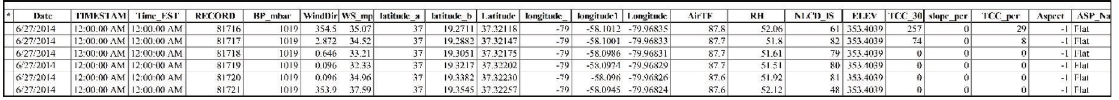
Figure 9: Screenshot illustrating of a portion of the GIS attribute table for mobile temperature collection date 27 June